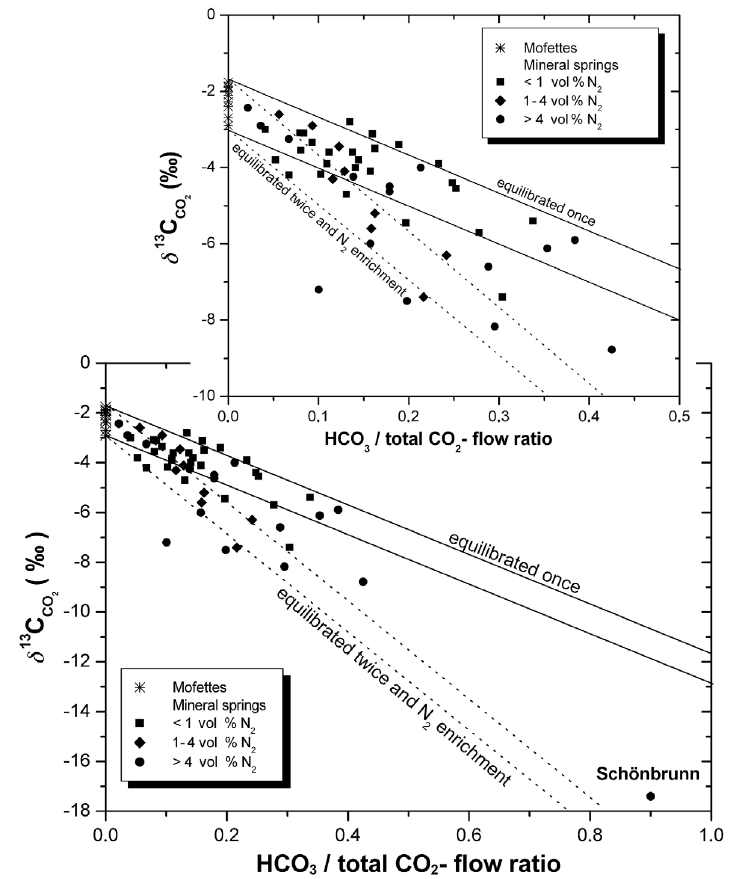
Fig. 5. Dependence of δ 13 C CO2 values in free gas phase from the ratio of HCO 3 – transport ( m HCO 3 ) in water to total CO 2 flux in mineral springs and mofettes in the western Eger Rift with complete mass balances, according to the isotope balance formula (see text) (data of HCO 3 – , dissolved CO 2 and water discharge are taken from Kolárˇová and Myslil, 1979 and Weinlich et al ., 1999, 2003). Lines starting from the scattering range of the dry gas vents (on the y axis) in the mofettes wrap the field of theoretical fractionation according to the fractionation factor ε HCO 3-gas at 10°C. Between these lines, the δ 13 C values for the free gas are exclusively a result of frac- tionation by the means of formed HCO 3 – during a single equilibration, without the necessity to assume an addi- tional biogenic carbon. The δ 13 C values below the lines can be explained by twice equilibration. This results in an increase of N 2 . Multiple equilibrations with solely dissolved CO 2 and single equilibration with HCO 3 – result in occurrence of N 2 -richer gases, which fall in between the fractionation